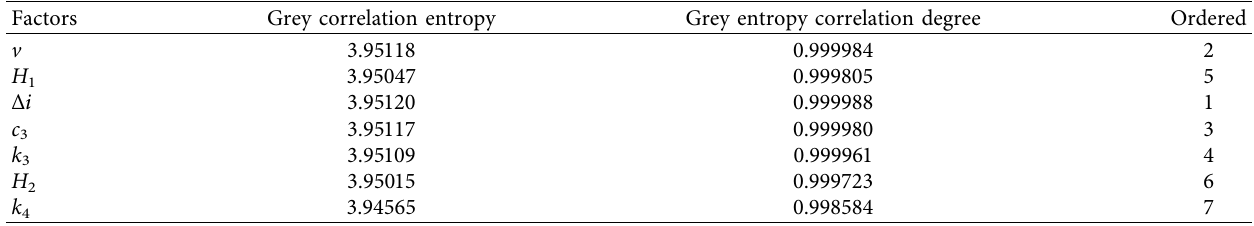
Table 5: Computed results and ordered correlation values of grey